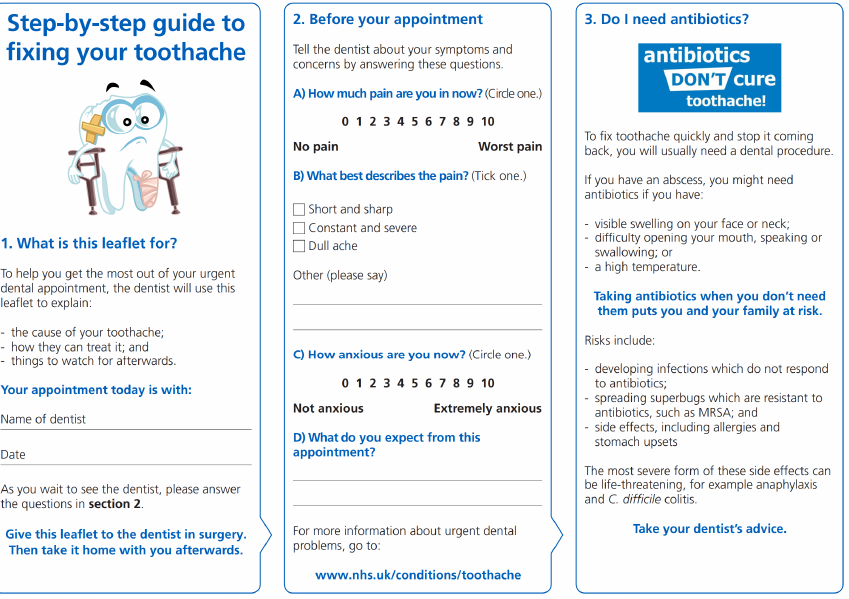
Figure 1. Side one of the shared decision-making worksheet, coproduced to optimise dental antibiotic prescribing during urgent dental appointments. Reproduced with permission of University of Leeds.